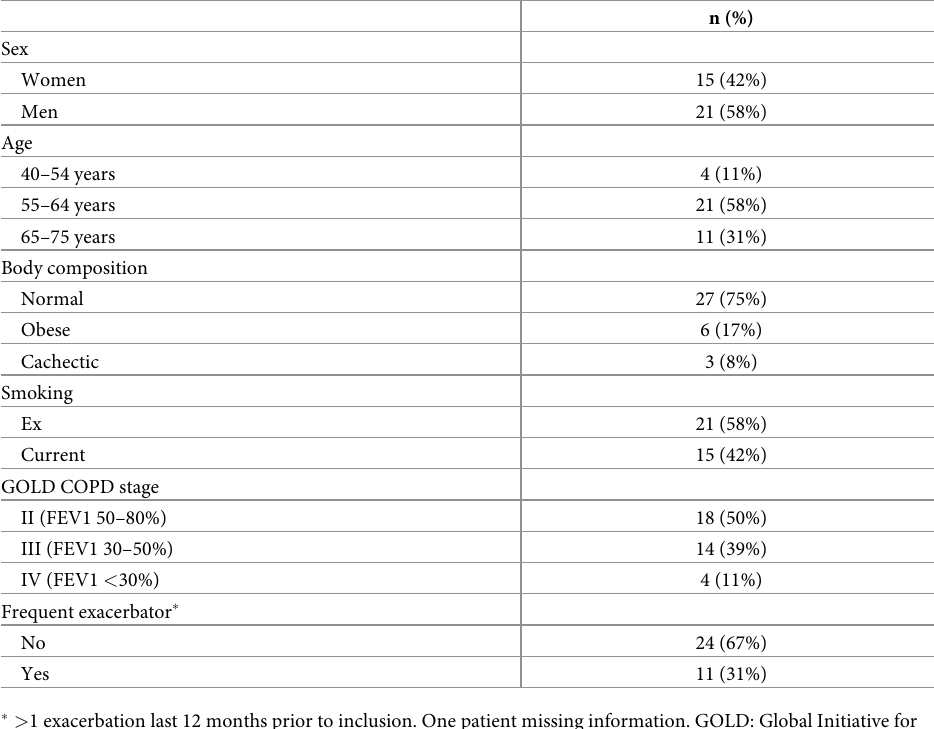
Table 1. Patient characteristics at inclusion in the Bergen COPD Cohort Study.